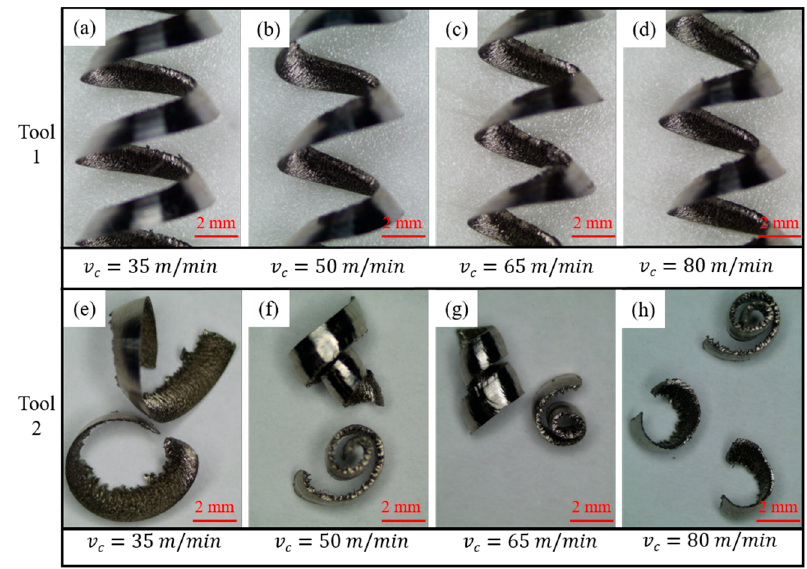
Figure 7. Comparison of chip shape and curl radius after cutting with two tools: ( a – d ) the chip shape and curl radius of Tool 1 at cutting speeds of 35, 50, 65 and 80 m/min, respectively, ( e – h ) the chip shape and curl radius of Tool 2 at cutting speeds of 35, 50, 65 and 80 m/min,